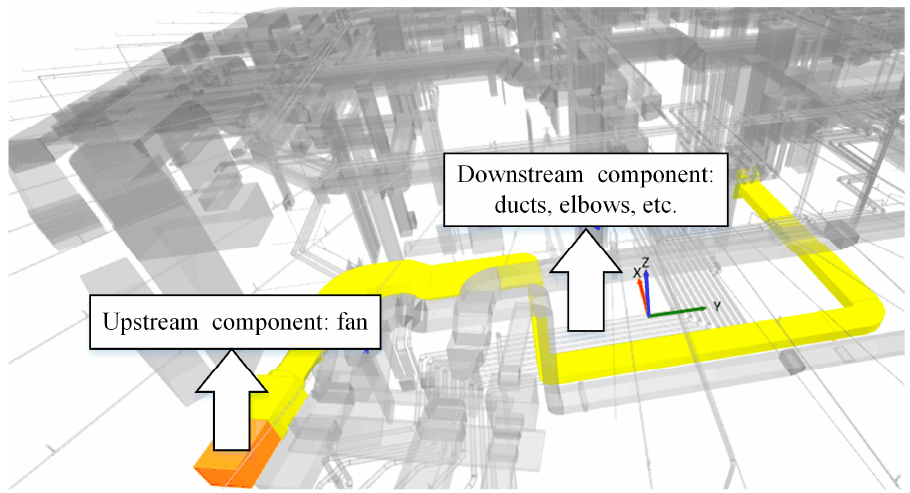
Figure 1. Typical logic chain in the subsystem of HVAC.